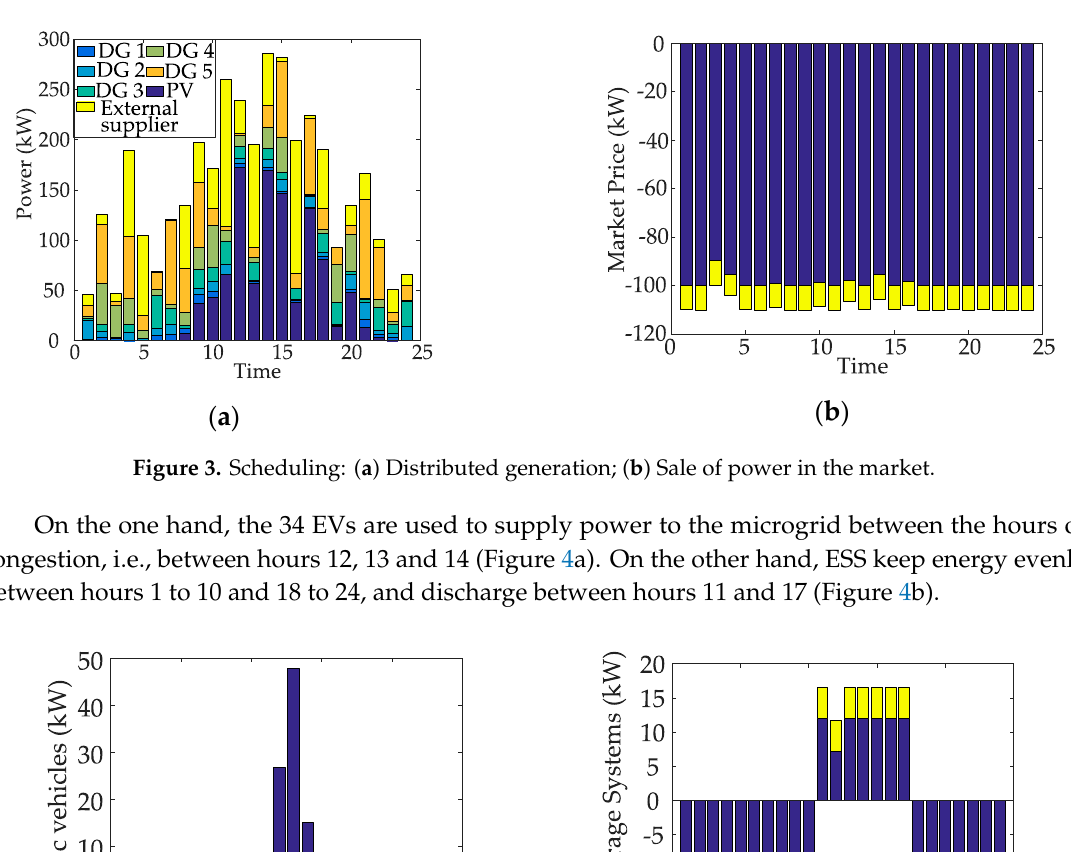
Figure 4. Discharge and charge: ( a ) EVs; ( b ) ESS.